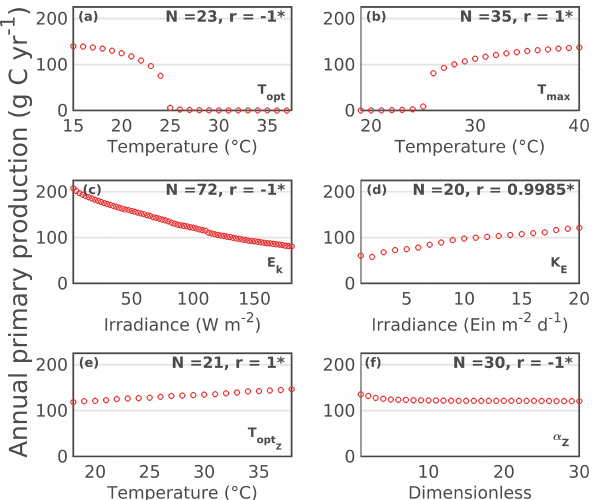
Figure 13. Sensitivity analysis of the 2008 simulated annual pri- mary production of MPB according to (a) the temperature optimum for MPB growth ( T opt ), (b) the temperature maximum for MPB growth ( T max ), (c) the light saturation parameter ( E k ), (d) the half- saturation constant for light use ( K E ), (e) the temperature optimum for grazing by P. ulvae ( T opt ), and (f) the shape parameter of the Z temperature grazing function ( α Z ). N is the number of tested values and r is the Spearman’s correlation coefficient (the asterisk indicates p value < 0 .